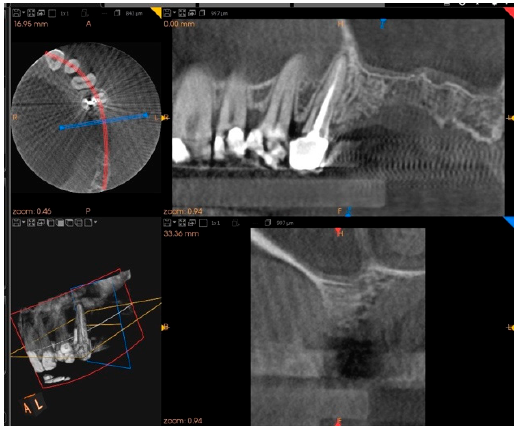
Figure 9. Cone-beam computed tomography (CBCT) shows bone volume preservation in the mesial surface of the alveolus.